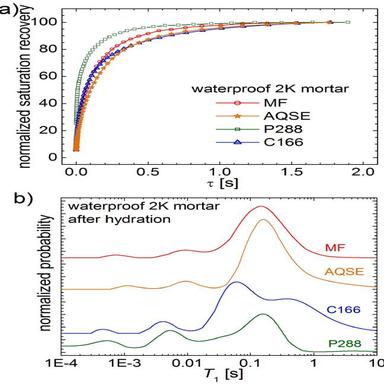
a) Normalized saturation recovery and b) T1 distribution for all the samples after hydration.